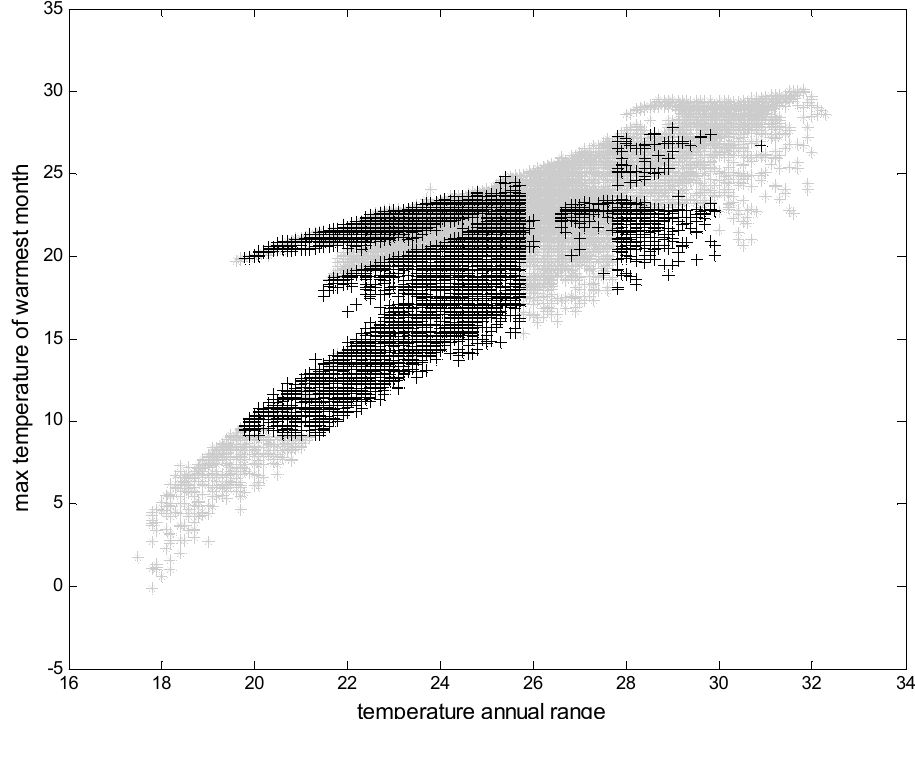
Figure 3. Modelled result of the ecological niche of the bank voles according to the temperature annual range and maximum temperature of the warmest months (°C). The black crosses represent the suitable ecological niche of the bank